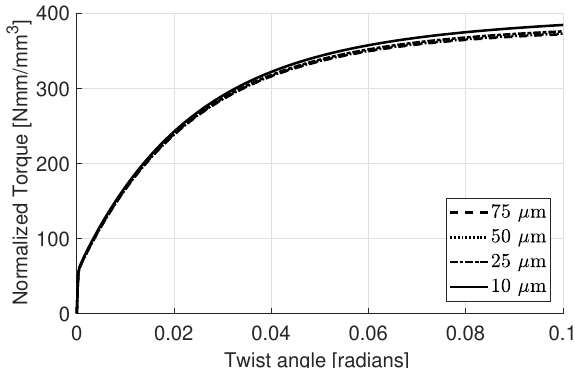
Figure 9. Torque vs. twist angle curves with varying disc radii using macroscopic plasticity